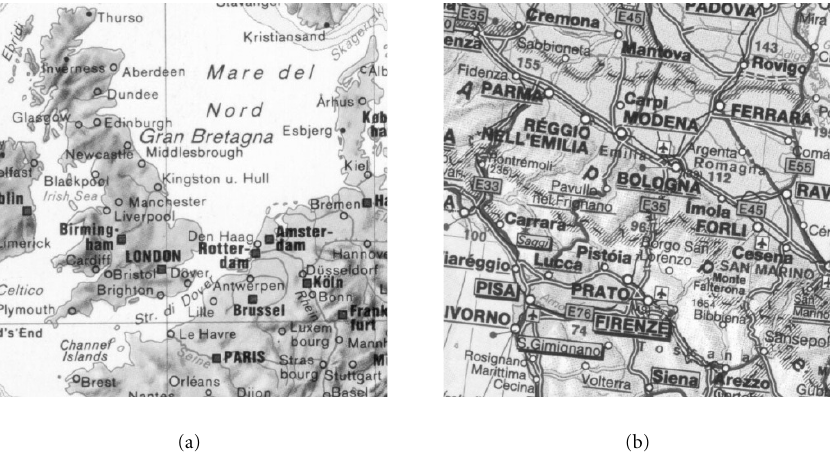
Figure 1: Examples of digital maps: (a) geographical map (EU600) and (b) road map (ITA600). The peculiarities of this kind of images, such as the contemporary presence of crisp contours, flat areas, and text, are clearly